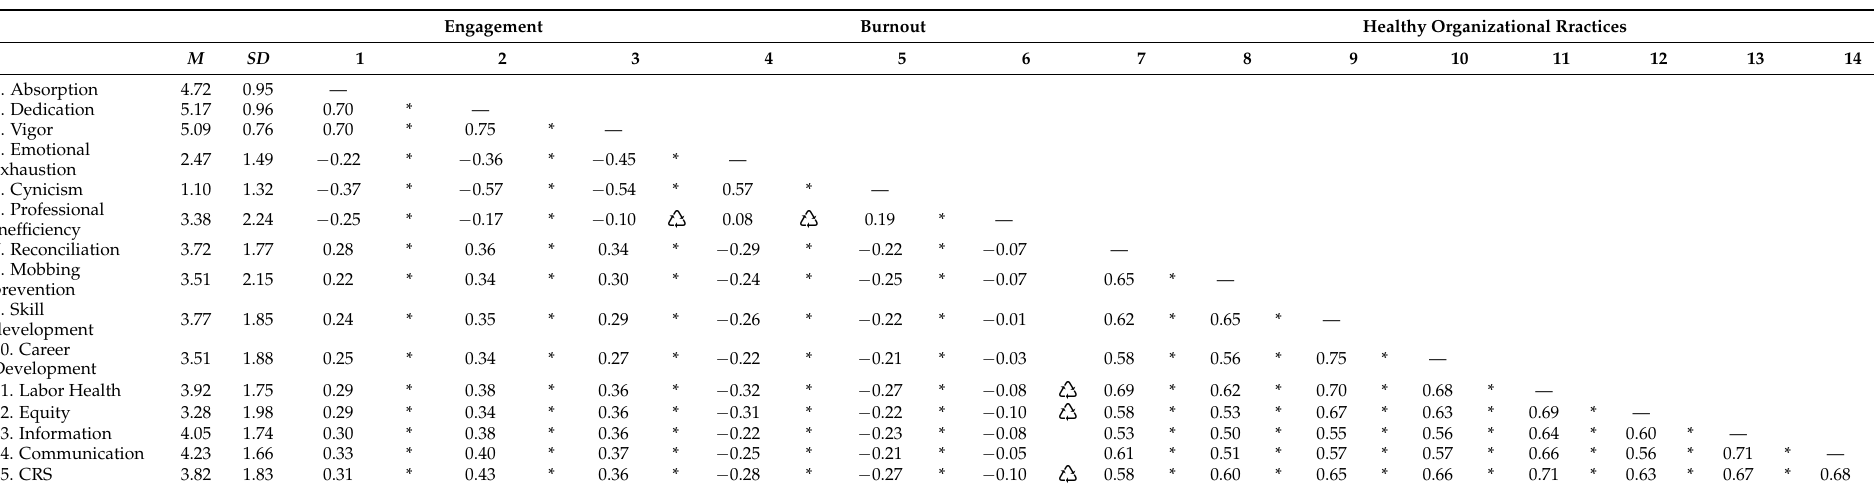
Table 1. Correlations among the perceptions of healthy organizational practices (HOP), worker engagement, and burnout. Engagement Burnout